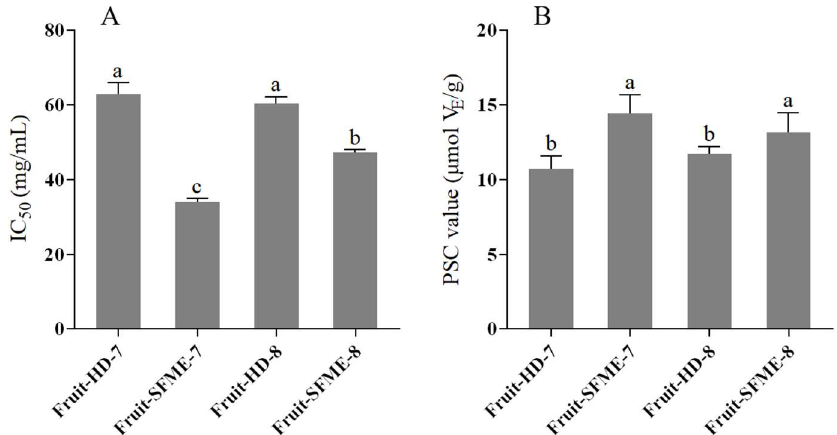
Figure 6. In vitro antioxidant activity of L. cubeba fruit essential oils from July (7) and August (8) obtained by hydrodistillation (HD) and solvent-free microwave extraction (SFME) techniques: ( A ) DPPH radical scavenging assay and ( B ) peroxyl radical scavenging capacity (PSC) assay. Columns with the different letter are significantly different at p < 0.05.